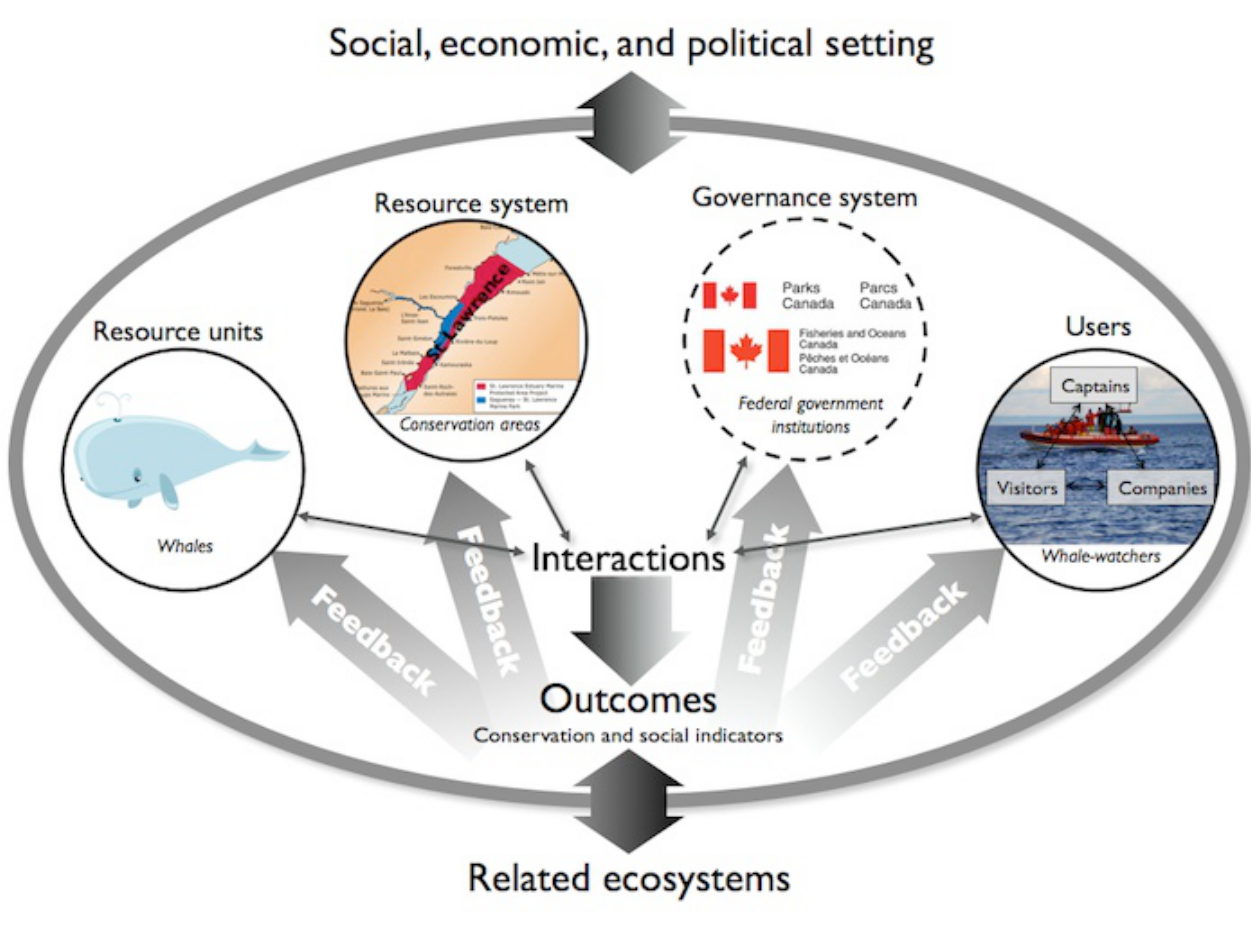
Fig. 5 . Conceptual diagram of the social-ecological system of whale-watching activities in the Saint Lawrence Estuary’s conservation areas, based on Ostrom’s framework (Ostrom 2009). The dashed lines encircle parts of the system that are not explicitly included in the